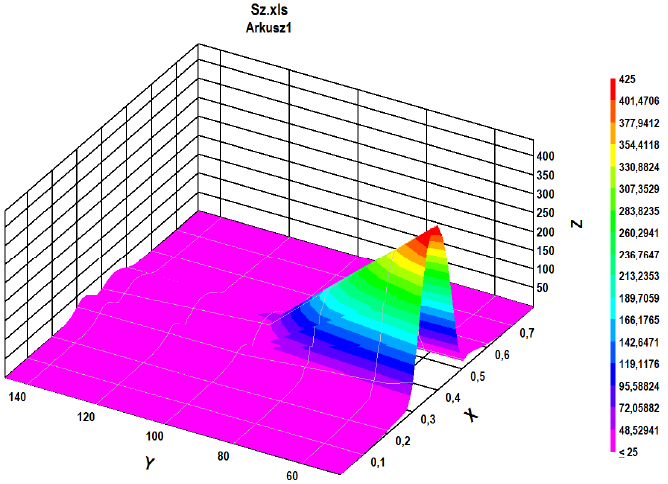
Figure 8. STFT form of the analyzed function shown in Figure 7 (X-time, Y-middle frequency of the STFT segment).